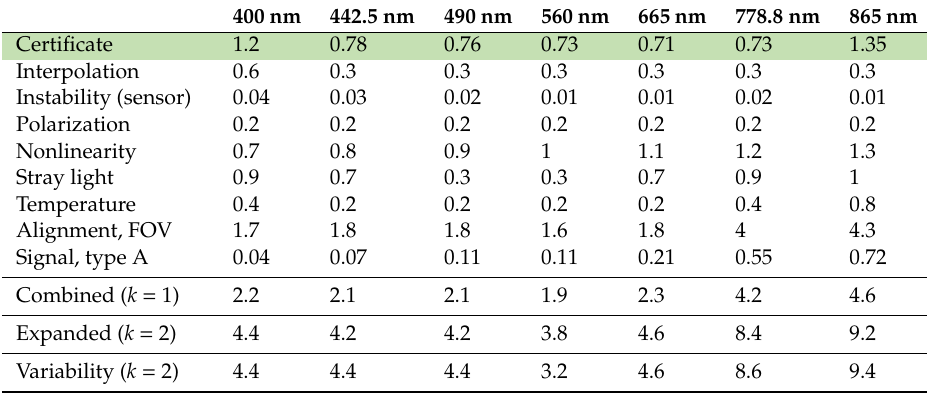
Table 6. Relative uncertainty budget for the radiance of sunlit water (in percent), based on the spread of individual sensors pointing to the same target during the outdoor comparison. Data highlighted in green are not used for combined and expanded uncertainties. Last row: Relative experimental variability of sensors evaluated from the results of field